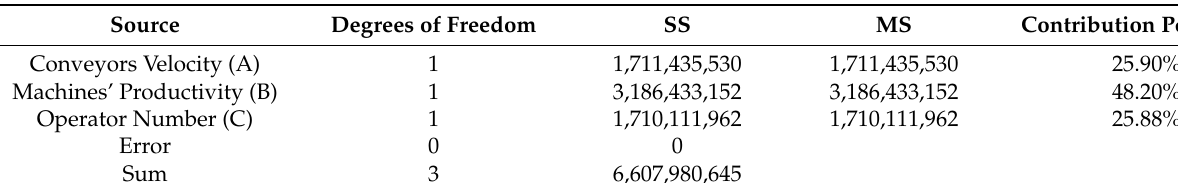
Table 14. ANOVA Table Excluding Error.